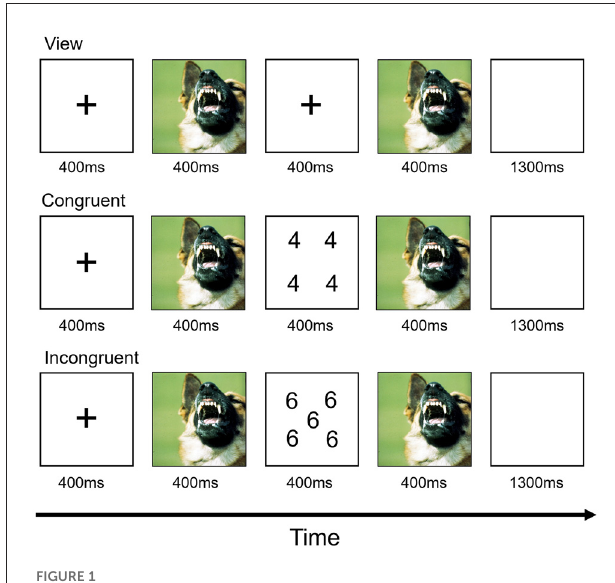
FIGURE1 Design of the affective Stroop fMRI